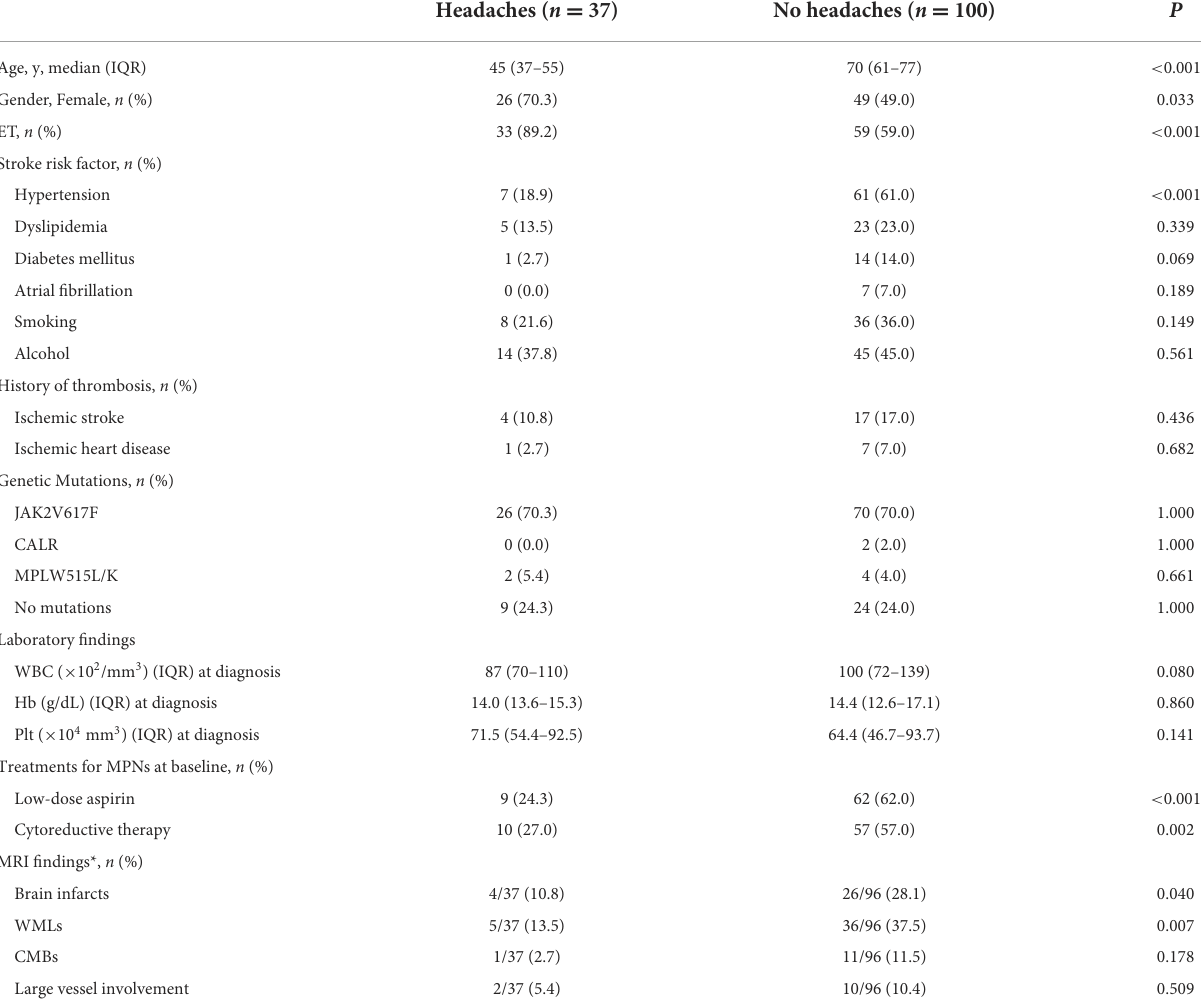
TABLE 2 Comparison of patients with headaches and without